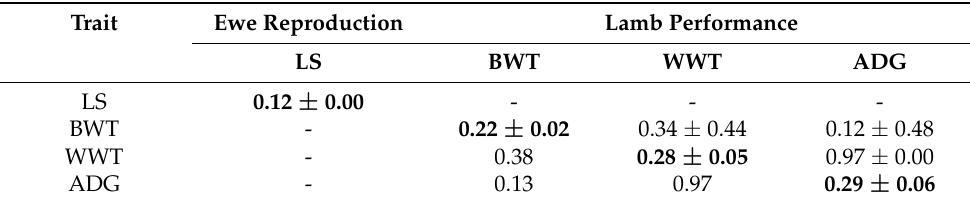
Table 2. Heritability (bold on diagonal), genetic correlation (above diagonal), and phenotypic correlation (below diagonal).